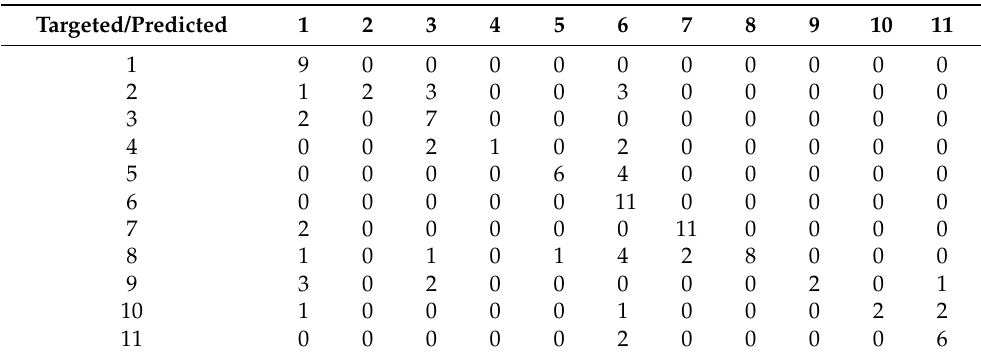
Table 5. The confusion matrix 3D Resnet101 [21].